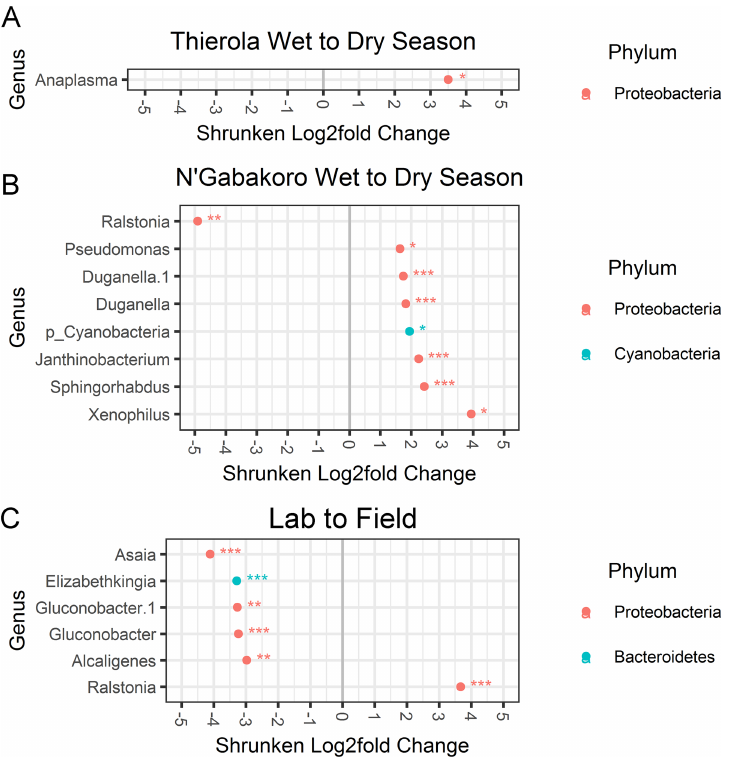
Fig 3. Hierarchical Multiple Testing (HMT) of differentially abundant 16s rRNA sequence variants. Log 2 fold changes calculated via DESeq2 greater than 1.5-fold that are significant at an adjusted p -value < 0.05 are presented for each location. HMT is a false discovery rate adjusting methodology that arranges tested hypotheses via their phylogeny, testing sub-hypotheses only if their parent hypothesis is significant. (cid:3) , (cid:3)(cid:3) , and (cid:3)(cid:3)(cid:3) represent significance levels of p-adj < 0.05, 0.01 and 0.001,